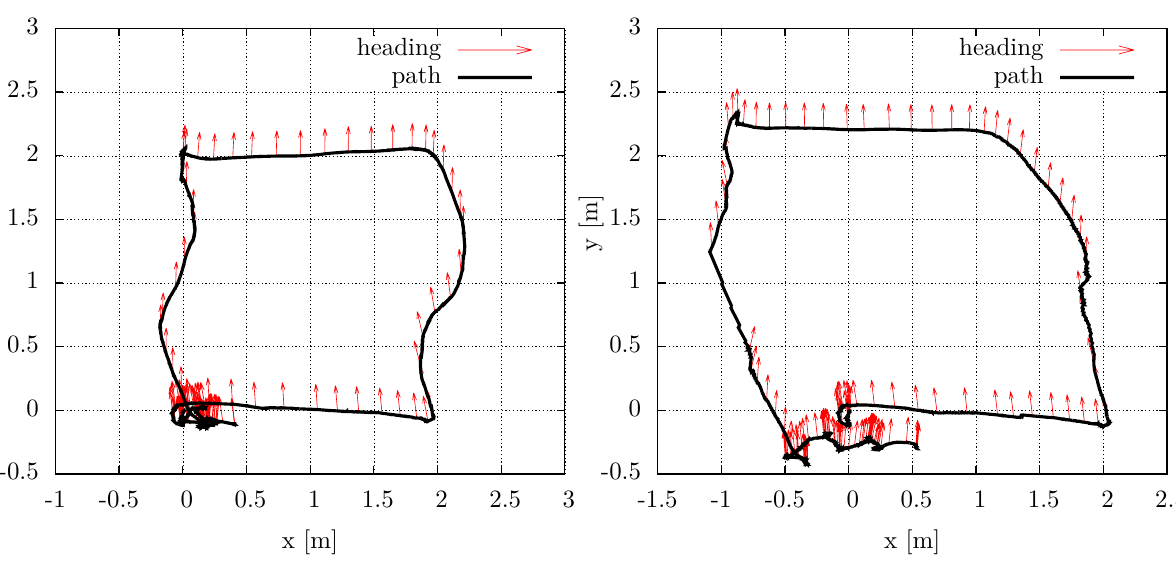
Figure 4. Example of a path tracked by the EKF. A square 2 m × 2 m was set up and quadrocopter was navigated (with PID controller) to its vertices using inertial localization only. Supposed position is shown on the left plot. As you can see, plot on the right shows more realistic pose and position thanks to visual localization (applied to the original data). Alas, we don’t have any reference data for absolute